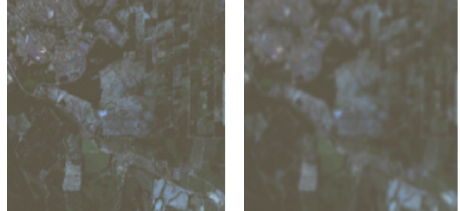
Figure 2. An example of HR 64x64 on the left and LR patch on the right after applying the Gaussian blur, sub-sampling and up-